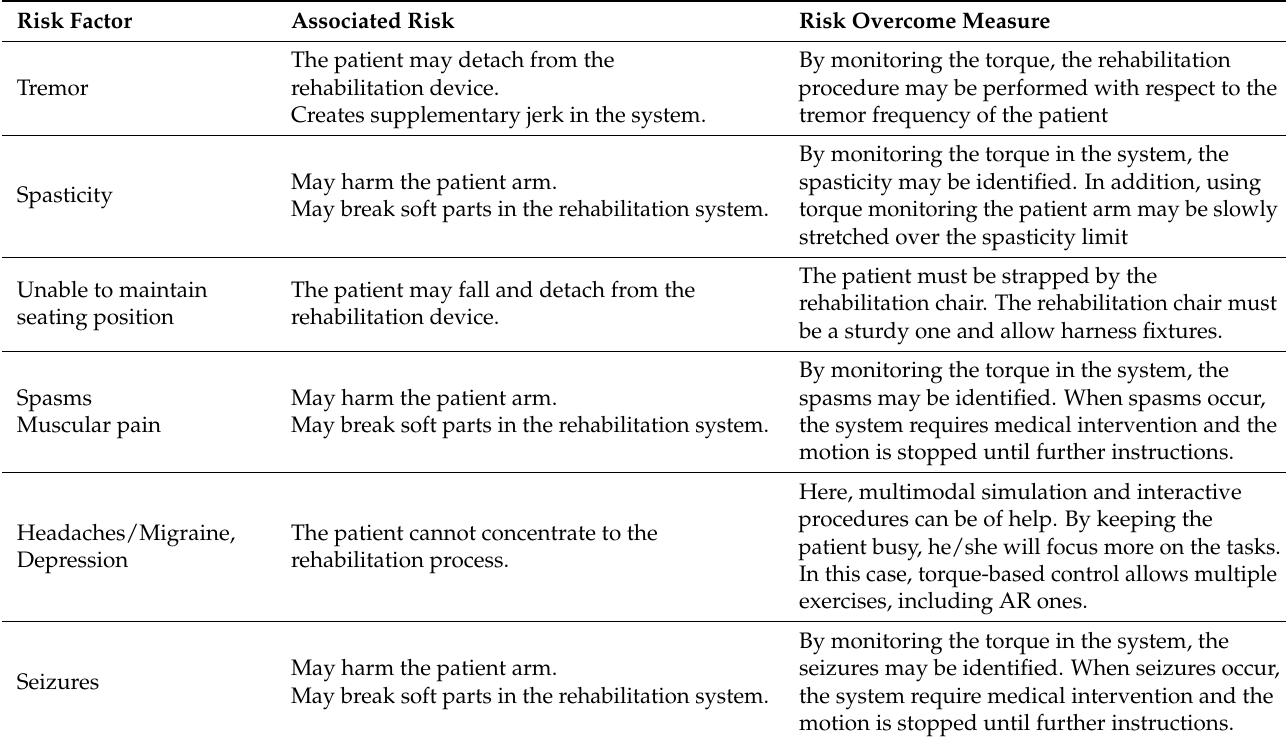
Table 1. Risk factors identified during the physical rehabilitation.